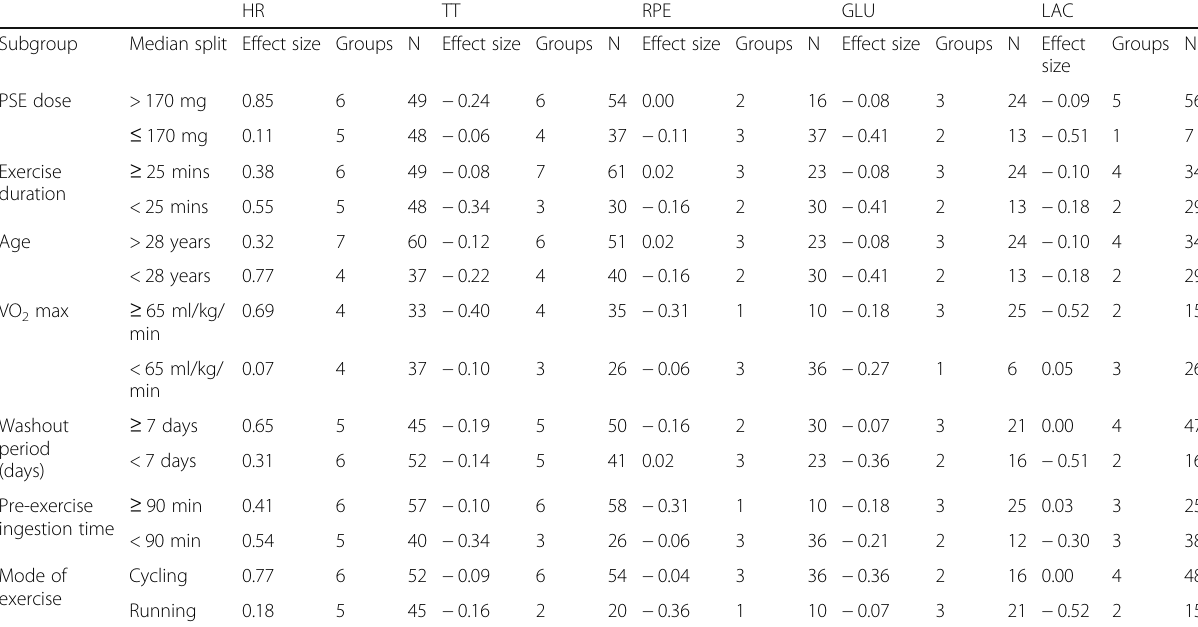
Table 3 Subgroup analysis HR TT RPE GLU LAC Subgroup